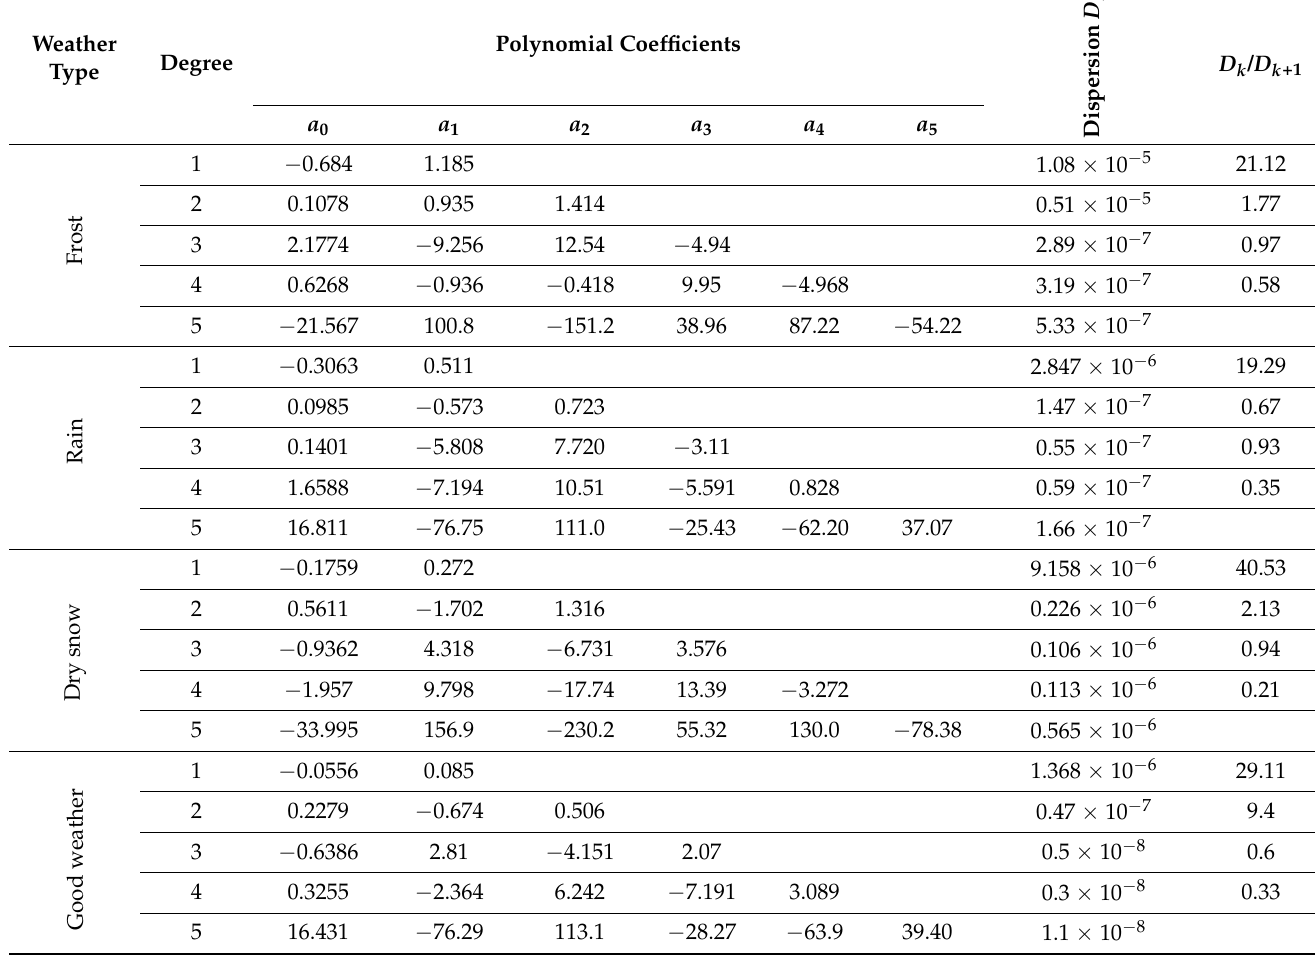
Table 2. Results of approximation and obtained coefficient of polynomials.